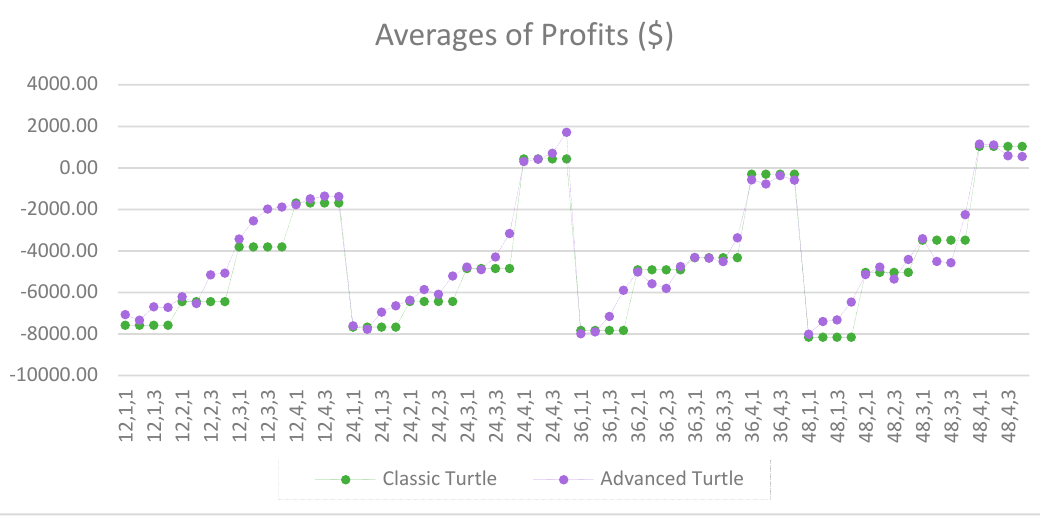
Figure 12. Averages of drawdowns as percentage of equity between the classic and the advanced Turtle systems for every combination of N, X, Y for the medium parameters (40, 80).